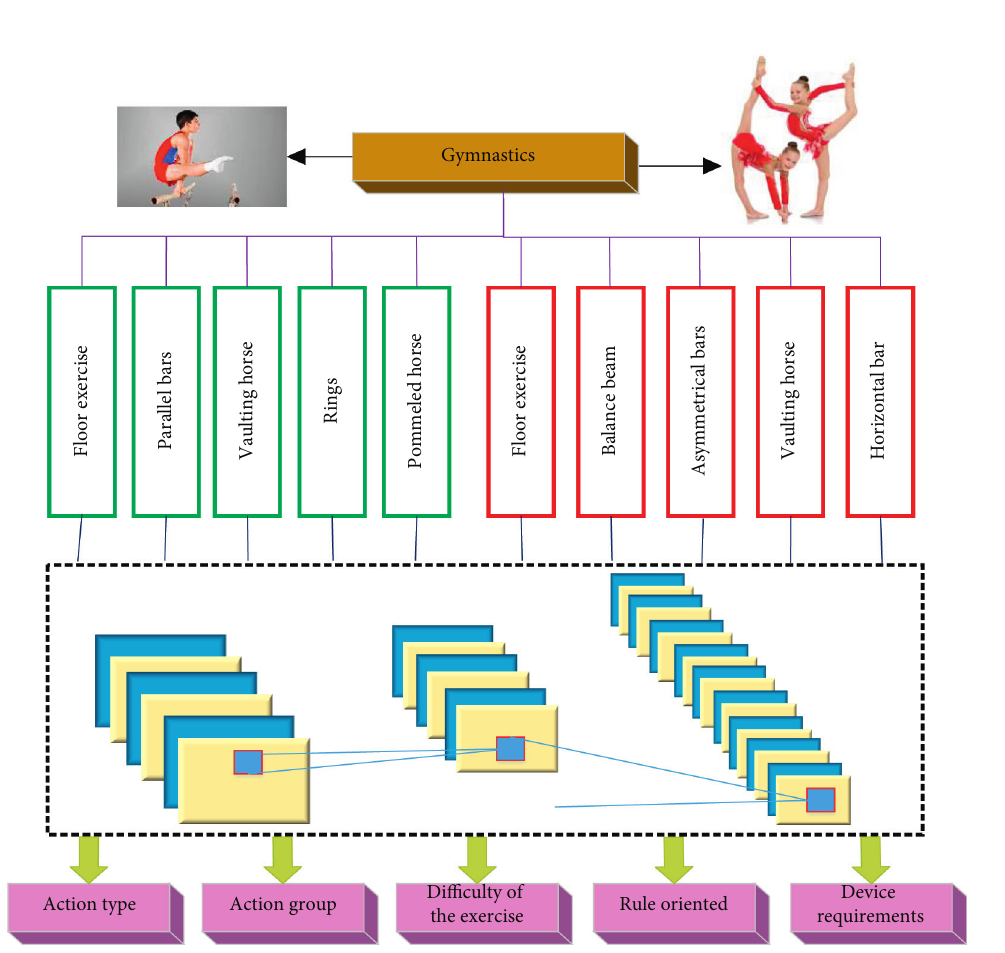
Figure 1: Schematic diagram of risk source determination of sports